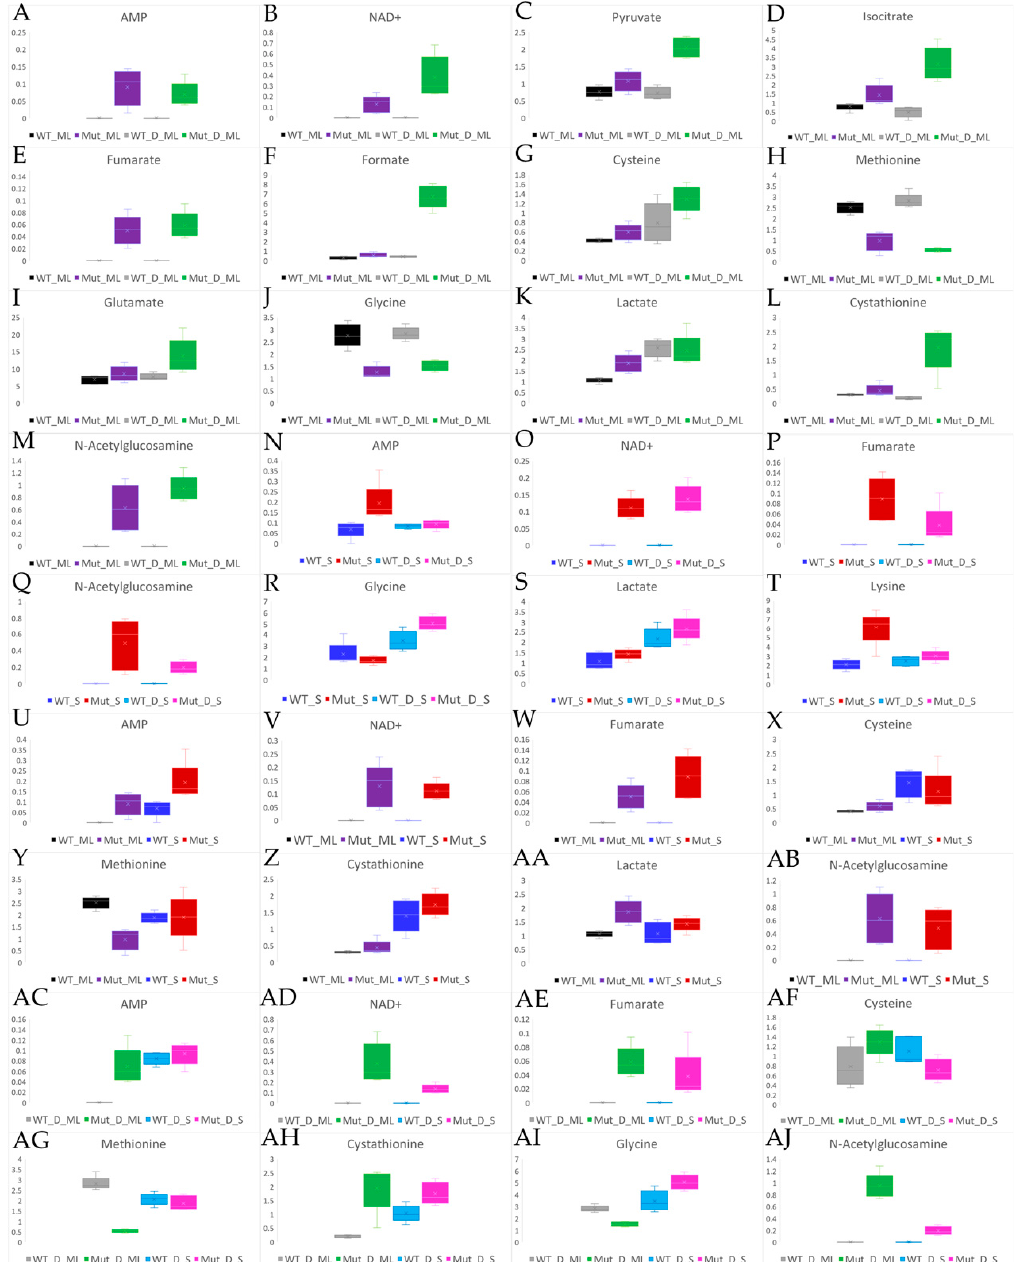
Figure 7. Box and whisker plots to show the differences in fold changes and the fold change ranges for example metabolites involved in peptidoglycan synthesis, membrane permeability and energy associated pathways. ( A – M ) Mid Log Phase Sample Comparisons. ( N – T ) Stationary Phase Sample Comparisons. ( U – AB ) Unchallenged Sample Comparisons. ( AC – AJ ) Challenged Sample Comparisons.